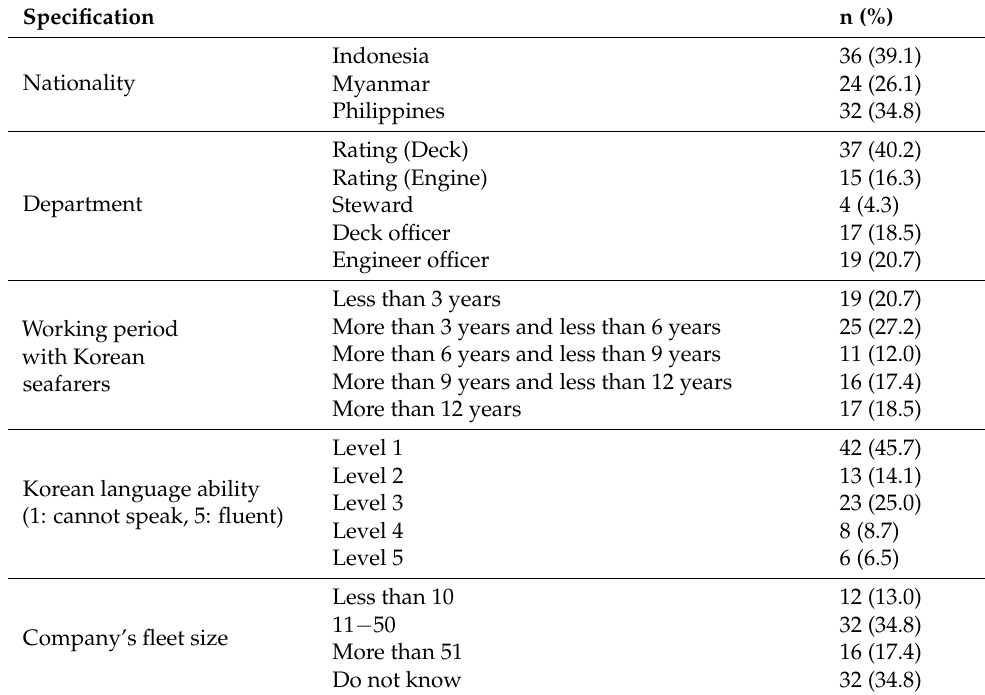
Table 1. Characteristics of foreign seafarers working in South Korea (n =